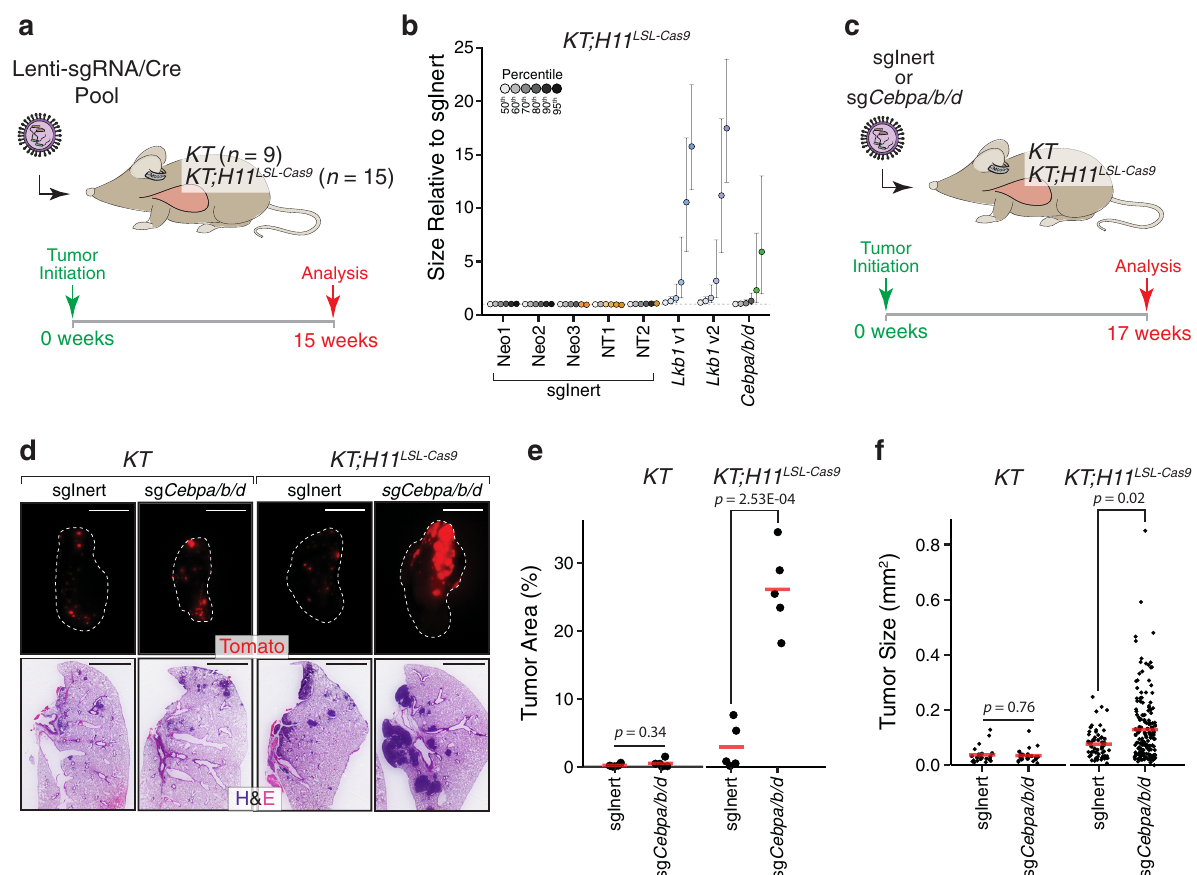
Fig. 5 C/EBP transcription factors constrain oncogenic KRAS-driven lung tumor growth. a Interrogation of the tumor-suppressive capacity of a series of LKB1-dependent genes and C/EBP transcription factors (targets listed in Supplementary Fig. 16b). Lenti-sgRNA/Cre vectors targeting each candidate gene were pooled prior to delivery into KT and KT;H11 LSL-Cas9 mice (method outlined in Supplementary Fig. 16b). b Bulk tumor-bearing lungs were analyzed by Tuba-seq. Percentile plot depicting tumor size at several percentiles relative to the distribution of tumors initiated with Lenti-sgRNA/Cre vectors encoding inert sgRNAs (sgNeo1, sgNeo2, sgNeo3, sgNT1, sgNT2). Lkb1 and C/ebp family targeting vectors are shown. Each vector has a distinct fi ll color, and fi ll saturation indicates percentile. Colored fi ll indicates that tumor size at a given percentile is signi fi cantly different from inert sgRNAs, while grayscale indicates no signi fi cant difference. Error bars indicate 95% con fi dence intervals centered on the mean of relative tumor size at a given percentile. c Validation of C/EBP factors as suppressors of oncogenic KRAS-driven tumor growth in a non-multiplexed format. Tumors were initiated in KT and KT;H11 LSL-Cas9 mice with either Lenti-sgInert/Cre (sgNeo1/sgNT1/sgNeo2; sgInert) or Lenti-sg Cebpa / b / d /Cre (sg Cebpa /sg Cebpb /sg Cebpd ; sgCebp a / b / d ). N = 5 mice per genotype-virus cohort. d Representative fl uorescence (top) and H&E (bottom) images of tumor-bearing lungs from KT and KT;H11 LSL-Cas9 mice transduced with either Lenti-sgInert/Cre or Lenti-sg Cebpa / b / d /Cre. Lung lobes within fl uorescent images are outlined in white. N = 5 mice per genotype-virus cohort. Top scale bars = 5 mm. Bottom scale bars = 2 mm. e , f Quanti fi cation of tumor area ( e ) and tumor size ( f ) by histological examination of tumor-bearing lungs from KT and KT;H11 LSL-Cas9 mice transduced with either Lenti-sgInert/Cre or Lenti-sg Cebpa / b / d /Cre. Each dot represents either individual mice ( e ) or individual tumors ( f ). Red crossbars indicate the mean. In e , n = 5 mice per genotype-virus cohort. One tissue section per mouse was analyzed. In f , KT -sgInert, n = 22 tumors; KT -sg Cebpa / b / d , n = 23 tumors; KT;H11 LSL-Cas9 -sgInert, n = 58 tumors; KT;H11 LSL-Cas9 - sg Cebpa / b / d , n = 167 tumors. P values were calculated by a two-sided unpaired t